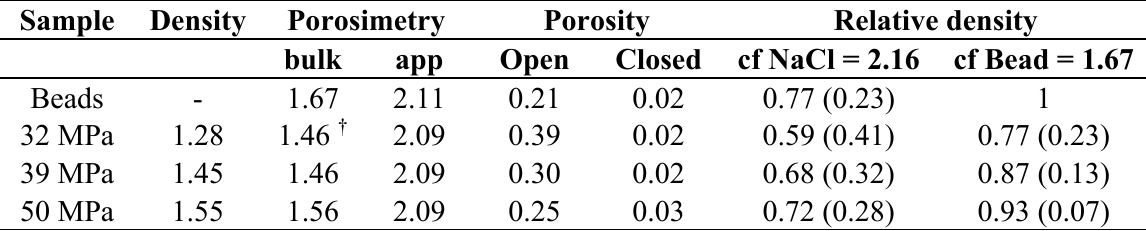
Table 1. Summary of the density data (in g/cm 3 ) from manual measurements and porosimetry along with calculated relative densities (and porosities in brackets) based on porosimetry data compared with either fully dense NaCl, or porous beads.